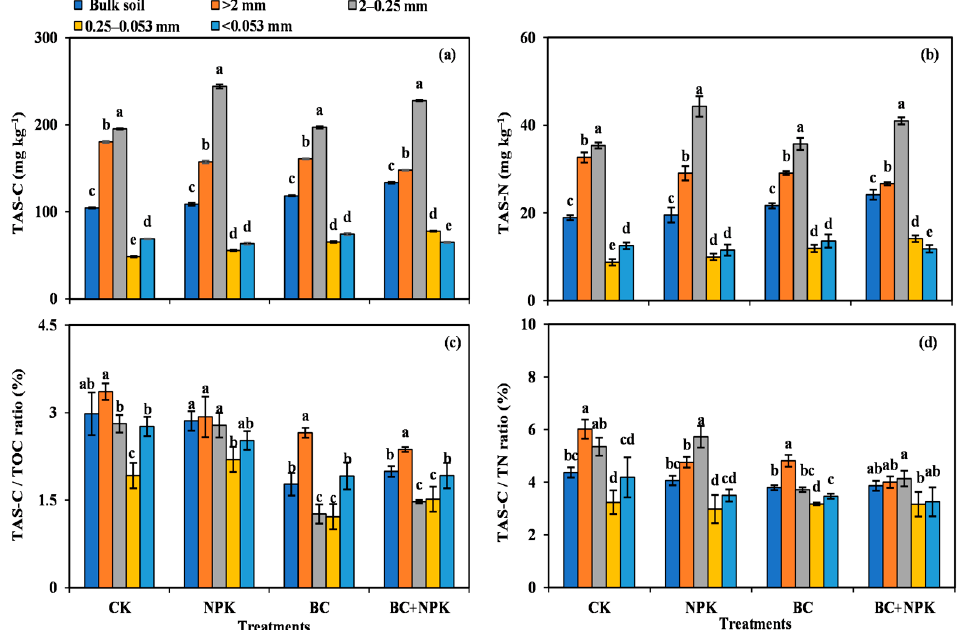
Figure 3. Amino sugar carbon and nitrogen contents in the bulk soil and aggregates among different treatments ( a , b ) and contribution of amino sugars to soil total organic carbon and total nitrogen ( c , d ). Error bars are the SD of mean from three duplicates. Diverse lowercase letters denote significant differences ( p < 0.05) among different particle sizes. Abbreviations: TAS-C and TAS-N, contents of amino sugar carbon and nitrogen.